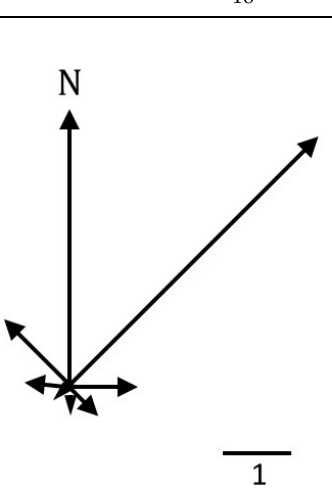
Figure 3. Fire spread direction multiplier imitating prevailing winds. Multipliers preferentially spread fire pixel to pixel. N is north. Table 2. Size distribution (ha) of fire events for the Black Mountains (UT) based on federal fire occurrence data from 1980 to 2016 and the Monitoring Trends in Burn Severity (MTBS) data from 1984 to 2016. For example, a size class of “ ≤ 4” indicates fire events were ≤ 4 ha.